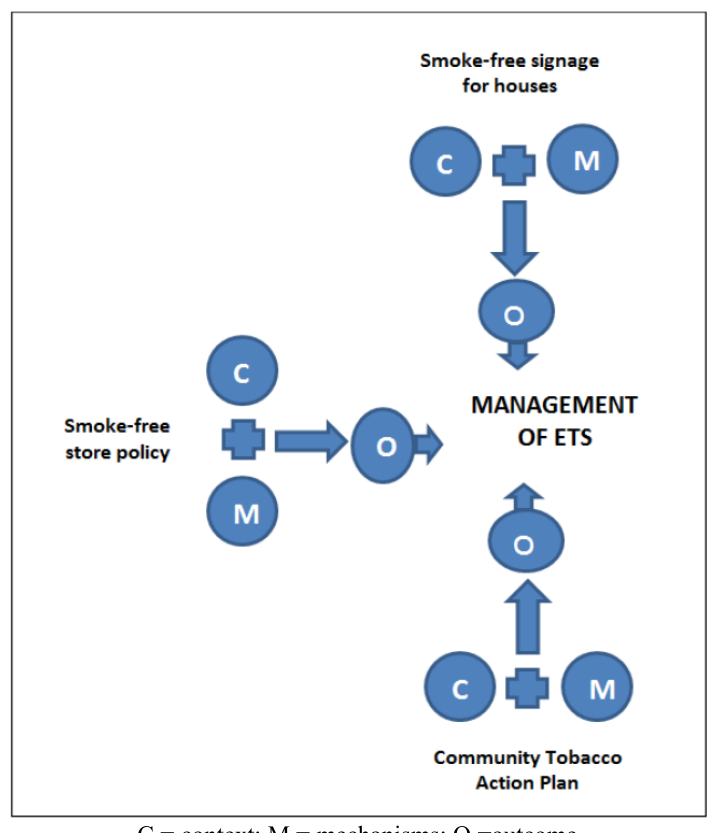
Figure 1. Logic diagram of case studies analysis (after Pointing